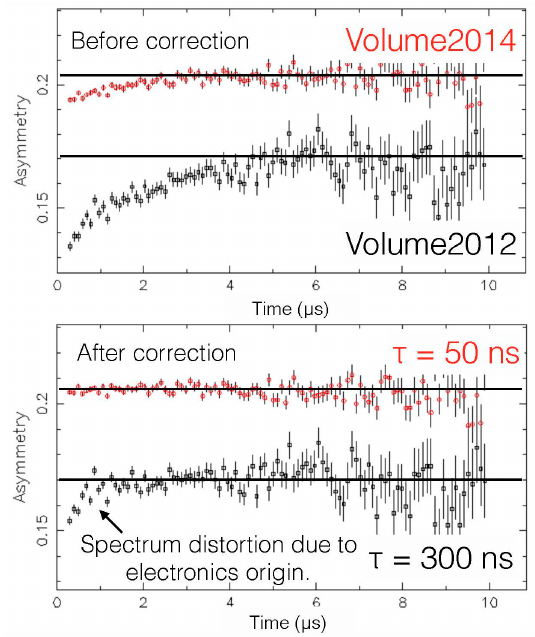
Figure 15. µSR time spectra obtained by S1-ARTEMIS with the earlier application-specific integrated circuit (ASIC) (“Volume2012”) and the latest ASIC (“Volume2014”). The top and bottom panels respectively depict the spectra before and after pileup correction using the standard formula N = N obs /(1 − τ N obs ), where τ is the dead-time parameter. (The Volume2012 spectra suffer from distortion due to the insufficient transient performances of the voltage